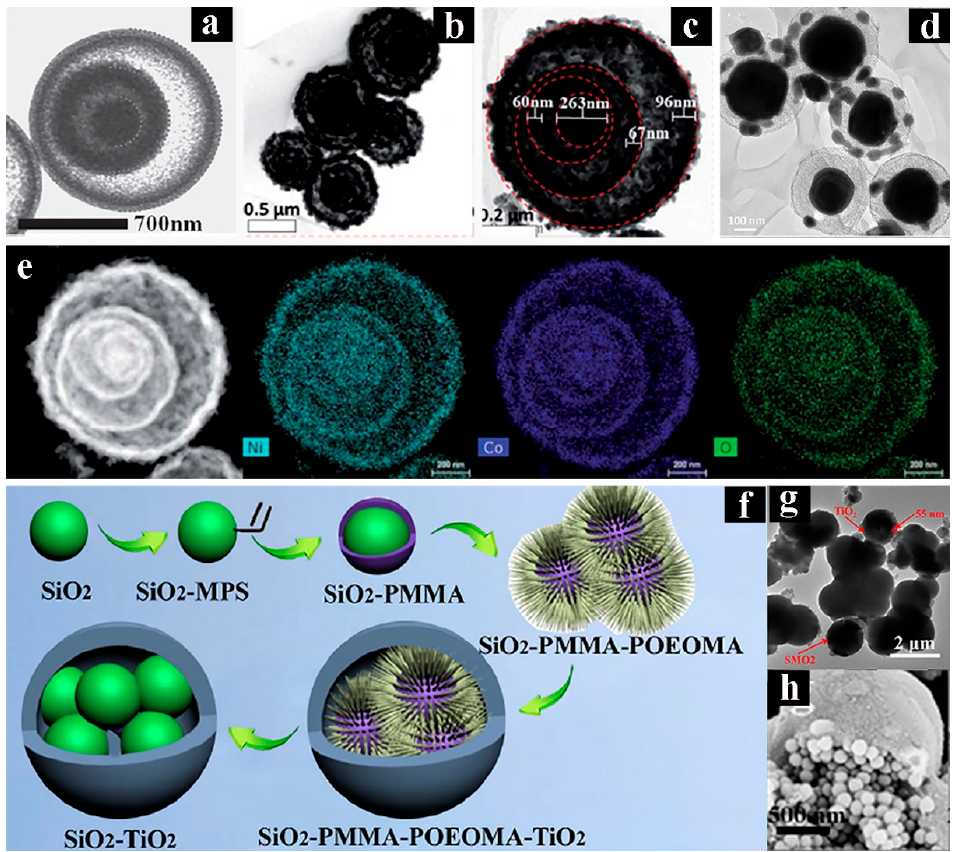
Figure 5. Schematic demonstration and graphical illustration of the yolk–shells and yolks–shell structure: ( a ) transmission electron microscopy (TEM) image of double shells with single yolk SnO 2 nanospheres. ( b , c ) TEM images and ( e ) element mapping images of triple shells with single yolk SnO 2